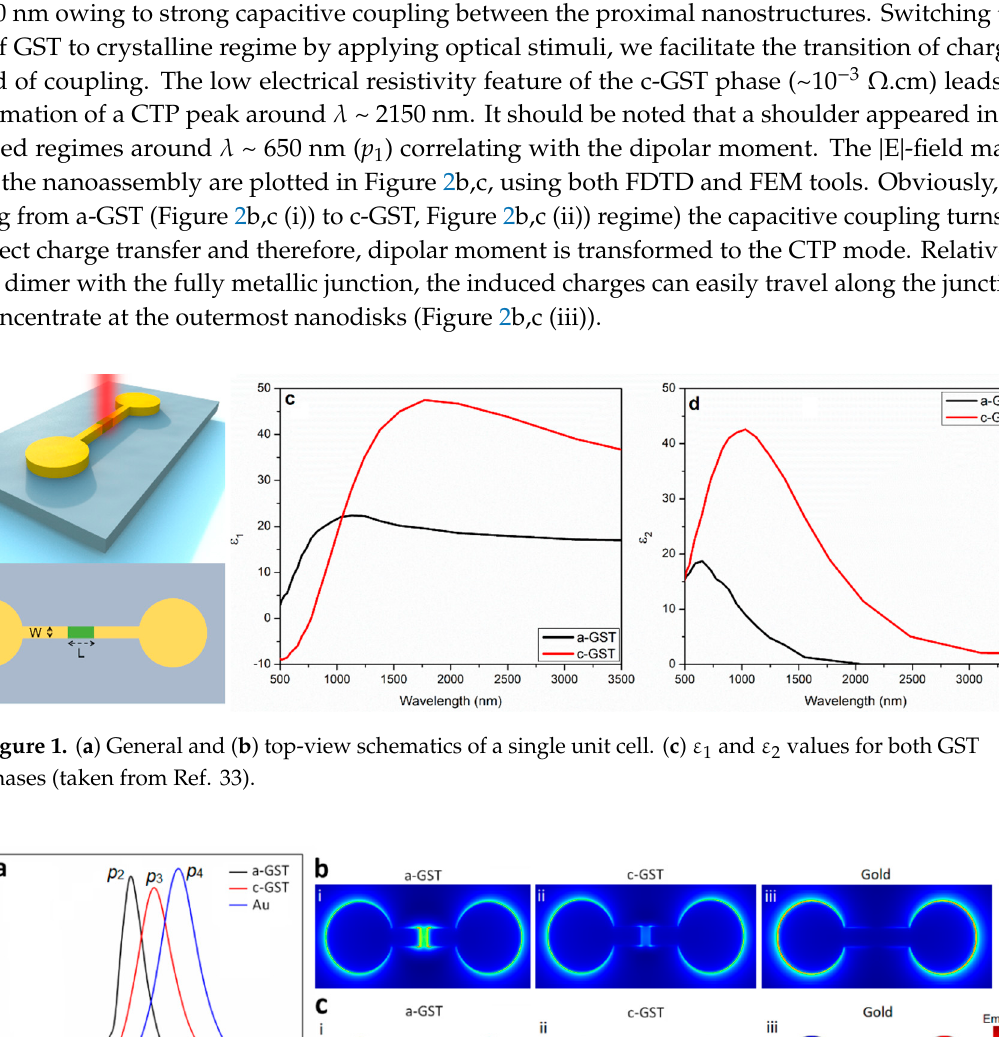
Figure 2. ( a ) Simulated extinction spectra of the plasmonic dimer platform for the junction with full Au, a- and c-GST sections. ( b ) The corresponding 2D |E|-field maps of the proposed system (FDTD): ( i ) dipolar mode ( p 2 ) at λ ~1880 nm for a-GST, ( ii ) CTP mode ( p 3 ) at λ ~2150 nm for c-GST, and CTP mode ( p 4 ) at λ ~2400 nm for full Au. ( c ) The associated 2D surface charge density maps of the design